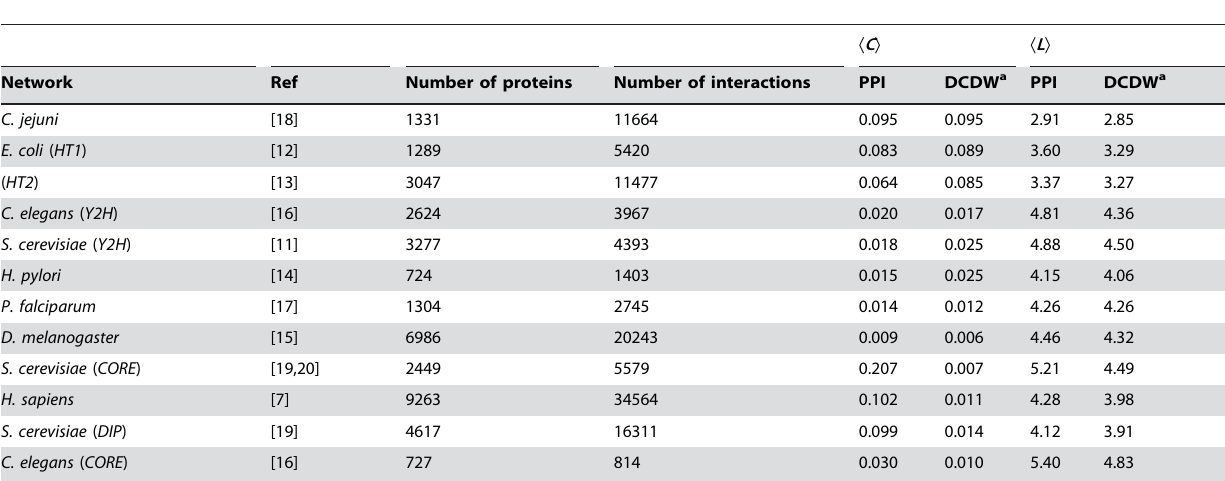
Table 1. Properties of 12 PPI Networks and Their Corresponding DCDW